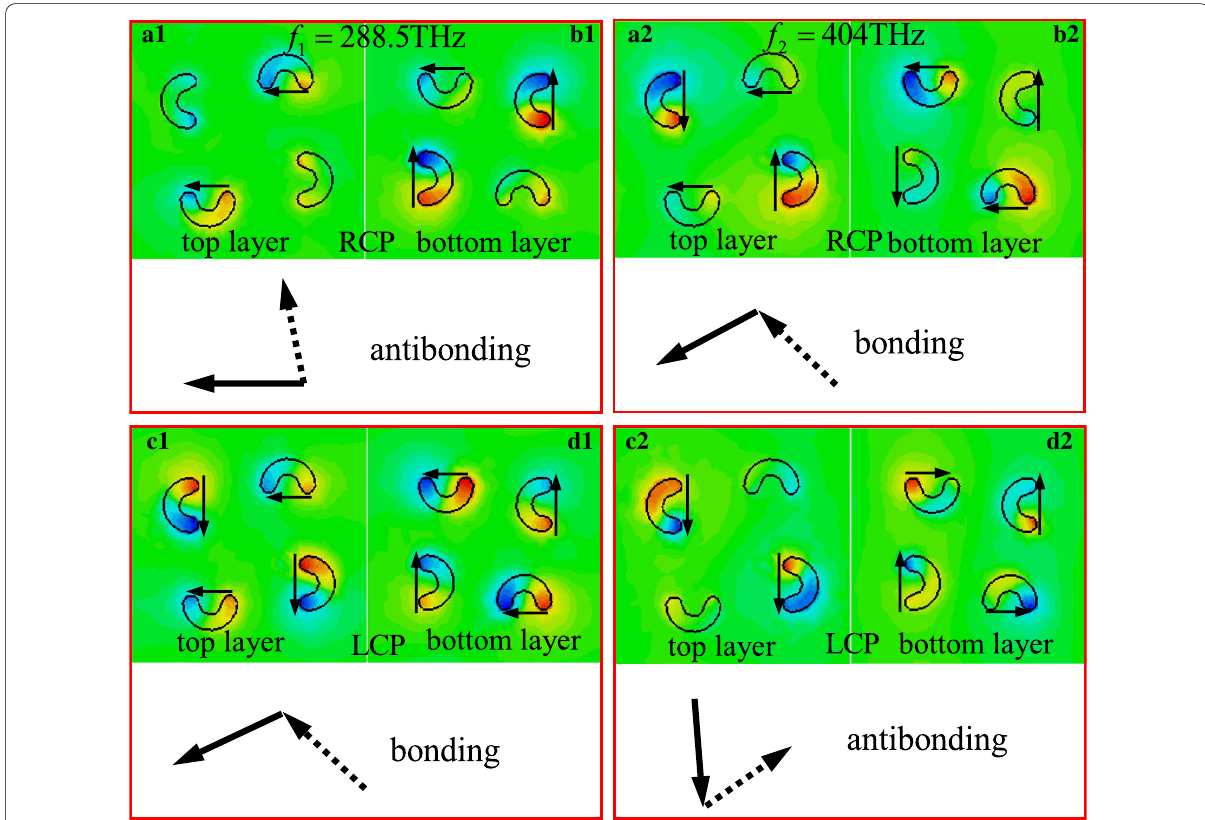
Fig. 5 The electric field ( E z ) distributions of unit-cell of the proposed CMSA induced by the ( a1 , b1 , a2 , b2 ) RCP and ( c1 , d1 , c2 , d2 ) LCP lights at different resonance frequencies: ( a1 – d1 ) f 1 288.5 THz, ( a2 – d2 ) f 2 404 THz. The black solid line (dash line) arrows denote the equivalent electric = = dipole moments on the top (bottom) layer of the proposed chiral